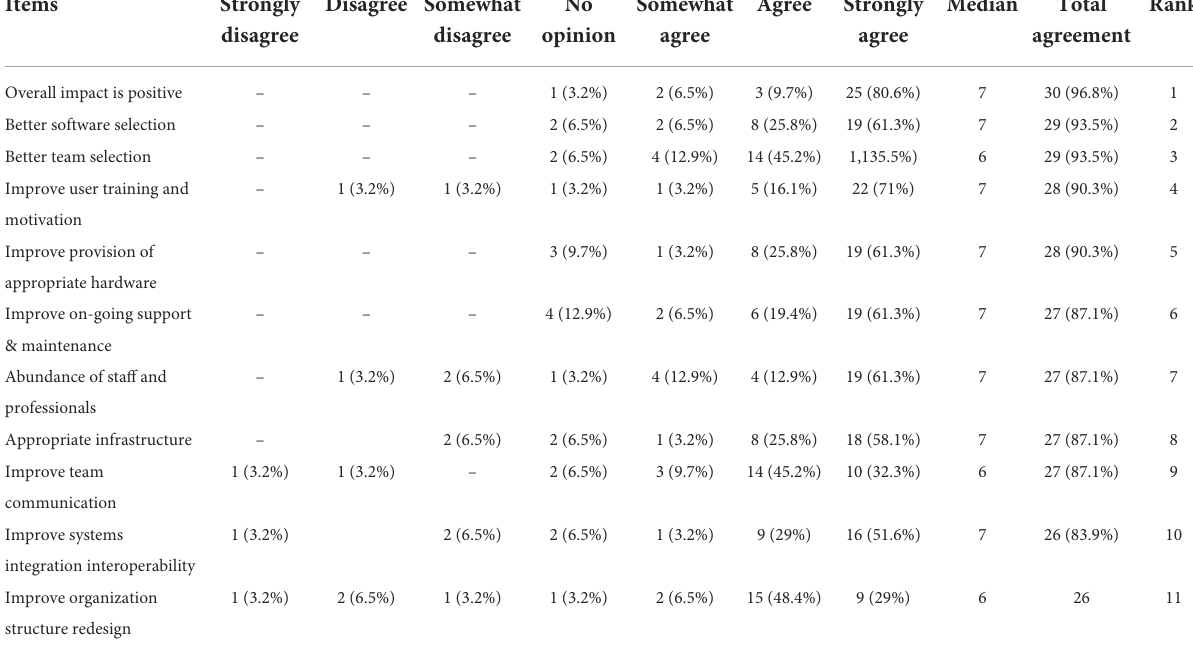
TABLE 2 Participant responses to items representing the impact of financial resources on EHRS implementation in